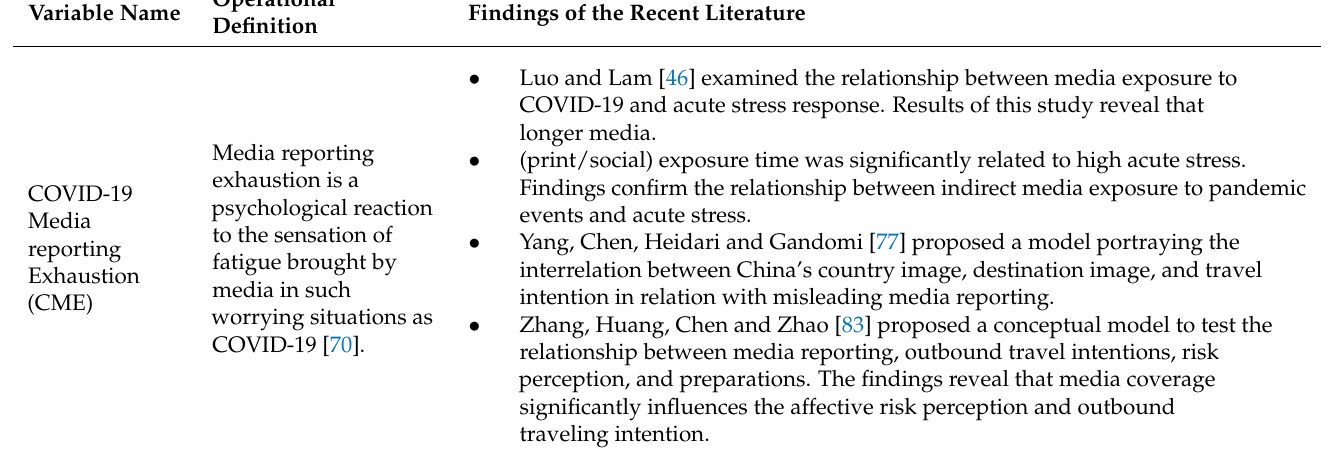
Table A1. Operational definition and relevance with the existing